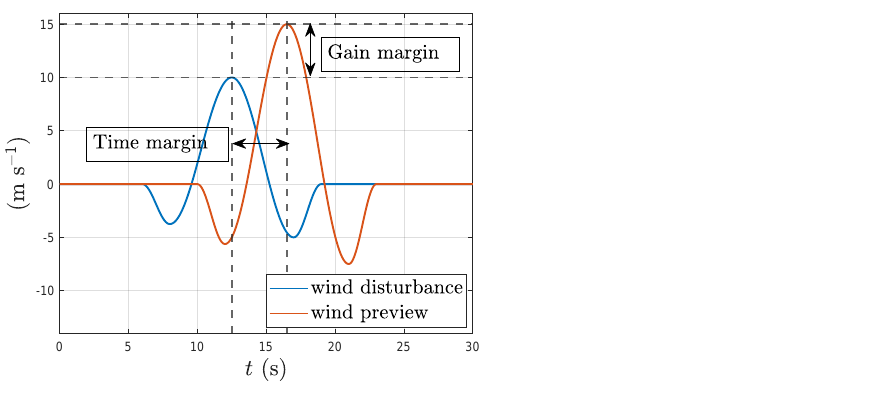
Figure 11. Representations of gust magnitude and time uncertainty used in robustness analysis. Table 5. rms Values of key system outputs for simulations with added uncertainty in the wind preview information used by MPC.Here Baseline refers to control configuration without wind